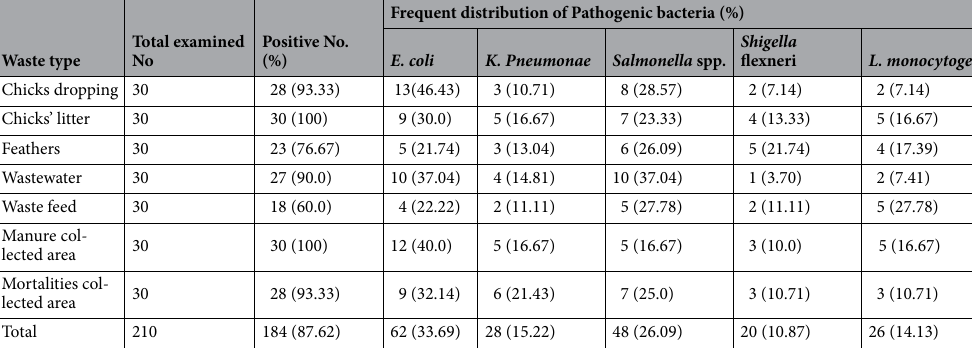
Table 2. Frequent distribution of pathogenic bacteria isolated from liquid and solid waste arising from investigated farms. The chi-square association of frequent distribution of bacterial isolates in examined samples is statistically significant at ( χ 2 ) = 96, P < 0.05.